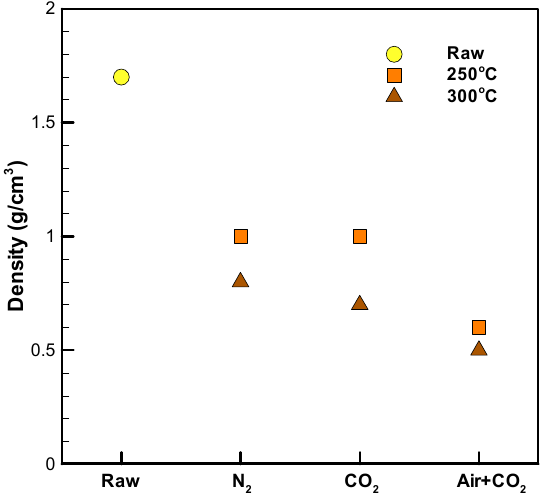
Figure 8. Profiles of density of raw and torrefied corncob